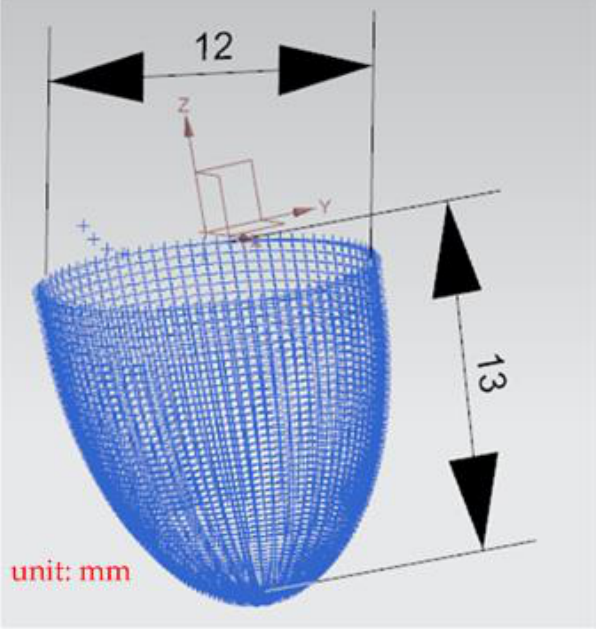
Figure 25. Spatial diagram of the converted concave circle finish machining.